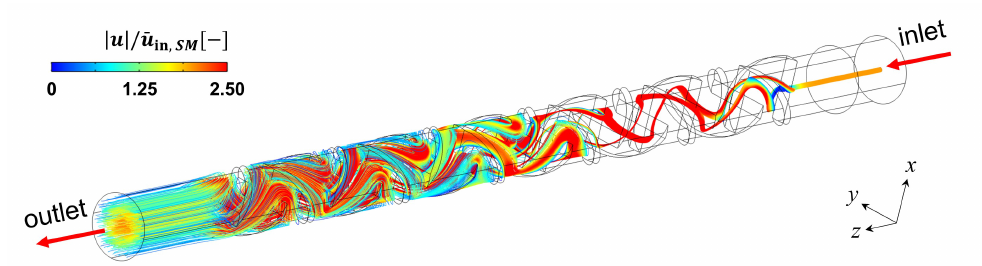
Figure 6. Streamlines evaluated from the center of the inlet where the salt spike was discharged through the syringe needle. The color of the streamline represents the velocity magnitude divided by ¯ u in , SM .